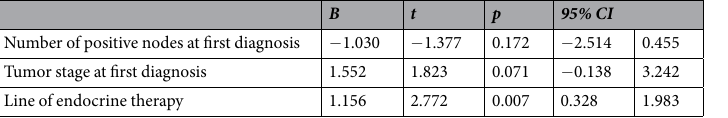
Table 2. Multivariate analyses of the associations between the number of somatic mutations and clinical